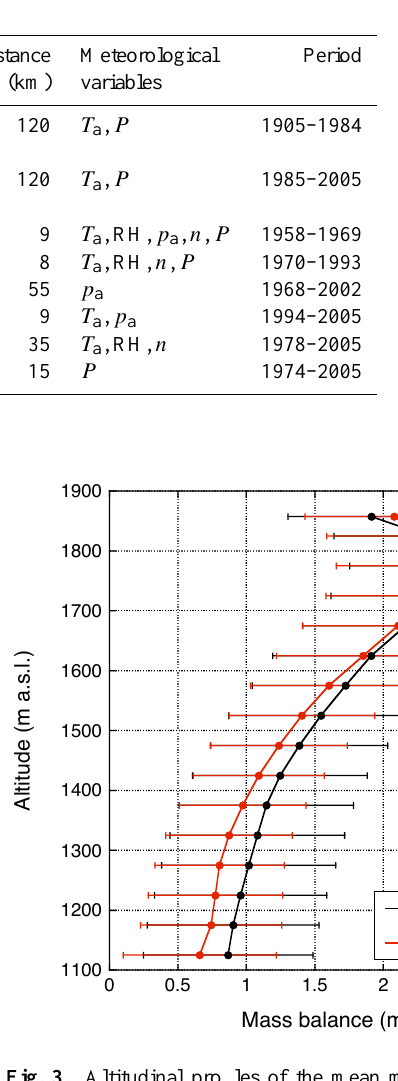
Table 2. NMI weather station information and overview of the data used as model input. Data from Voss Bø, Eidfjord Bu and Liset were used to supplement the records from the principal stations Slirå, Finse and Finsevatn, as described in the text. The distance given is the approximate distance to the centre of Hardangerjøkulen. The meteorological variables are indicated as T a (air temperature), RH (relative humidity), p a (air pressure), n (cloudiness) and P (precipitation).